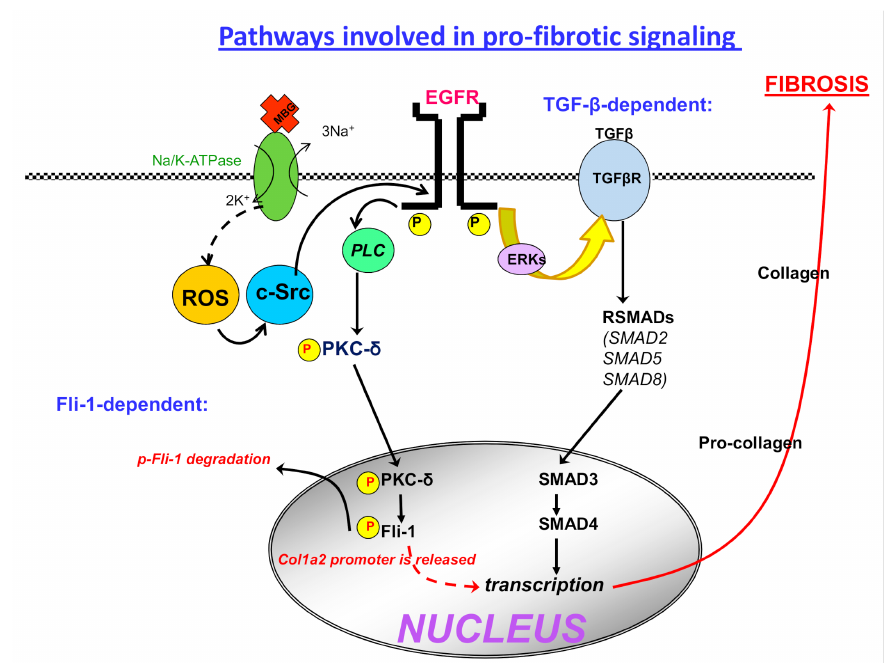
Figure 1. Schema of “signaling” pathways for CS effects. The “signaling” pathway involves the association of Src with the Na/K-ATPase. Binding of the CS to the Na/K-ATPase activates Src, which transactivates the epidermal growth factor receptor (EGFR) and phospholipase C (PLC). This leads to a generation of cascades that involve the generation of PKC- δ and activation of Fli1 or the activation of TGF- β and SMAD and finally the activation of collagen-1 and